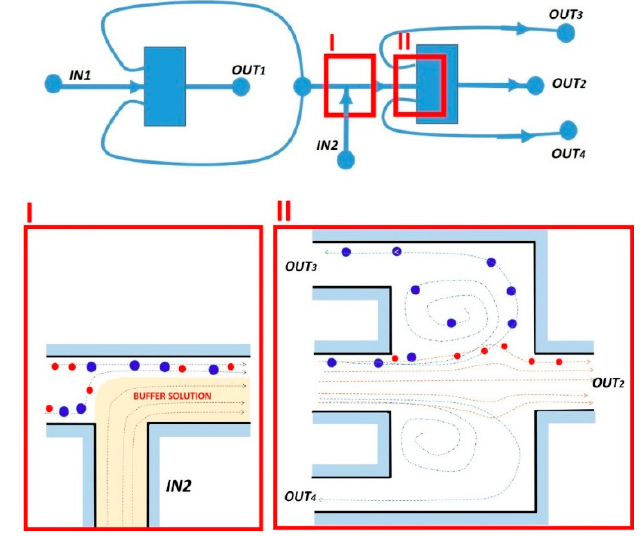
Figure 10. Schematic picture of two vortex sorting units integrated into a device for double sorting and purification. In the insets, a schematic detail of the device operation (I) at the second inlet stage IN2, and (II) in the second chamber. Adapted from [90].